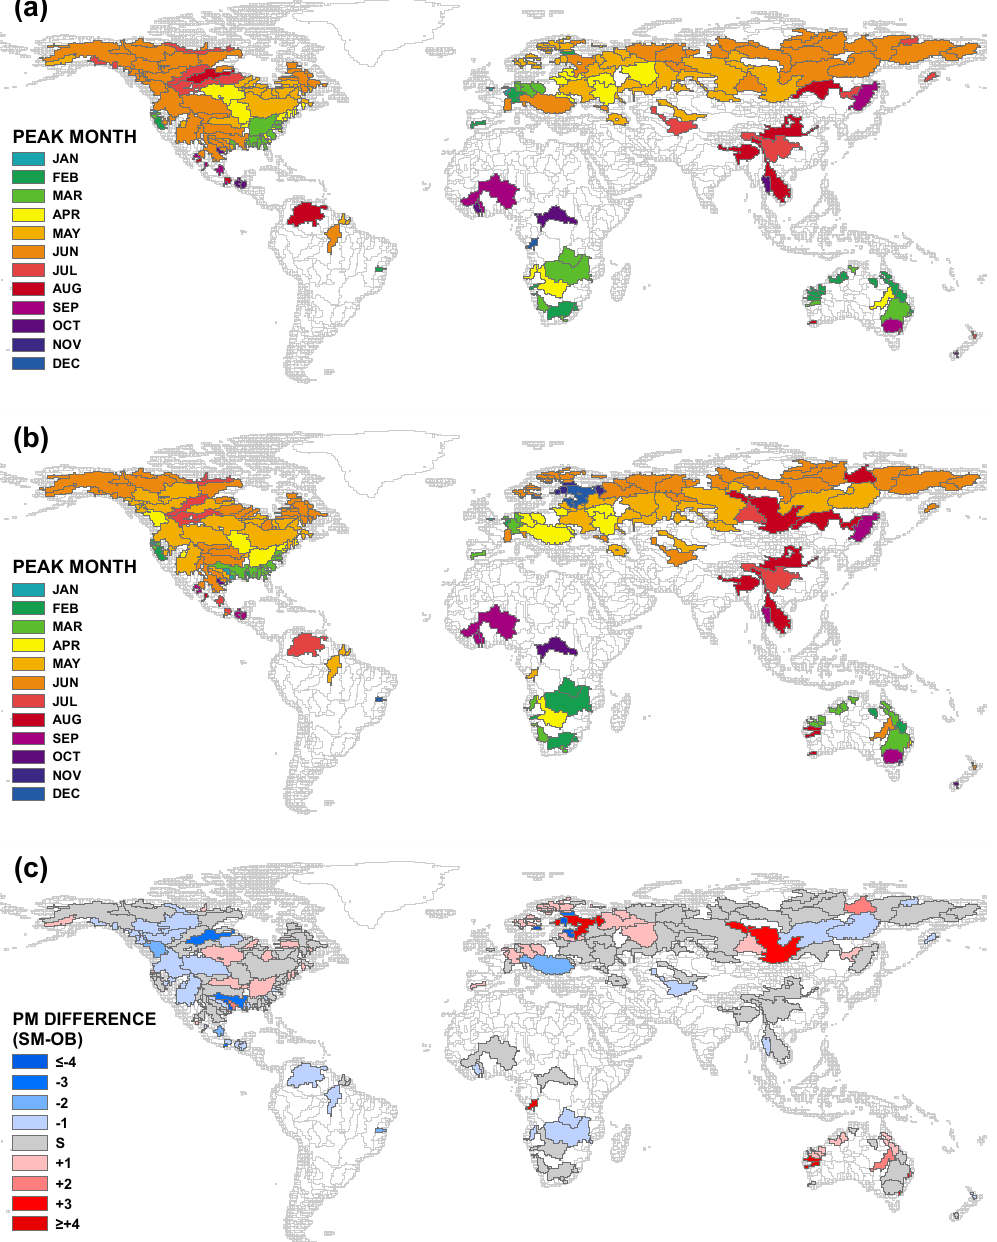
Figure 6. Peak month (PM) for flooding by sub-basin as defined by (a) 691 GRDC observation stations, (b) simulated streamflow at asso- ciated sub-basins and (c) temporal difference in PM between observations and simulation (simulation–observation, in number of months; a negative (positive) value indicates that the simulated PM is earlier (later) than the observed